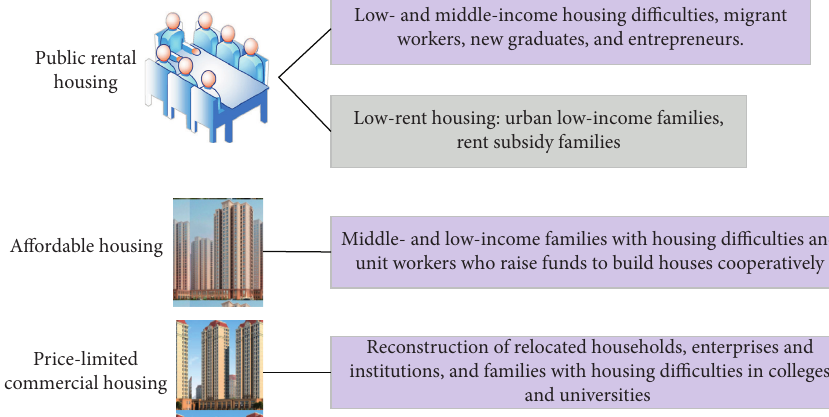
Figure 1: The coverage of security objects of the three types of housing.